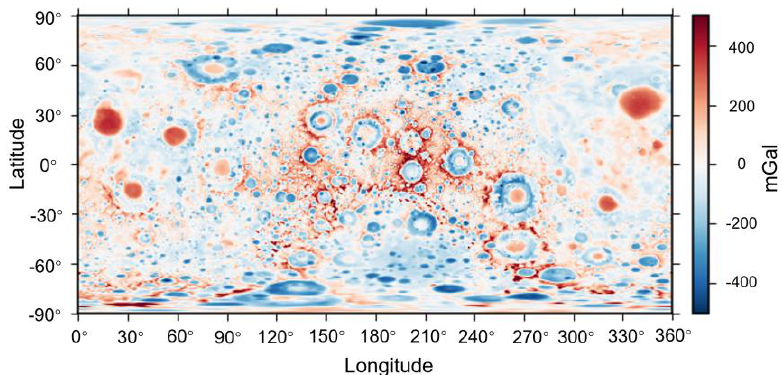
Figure 1. The gravity anomaly map including the gravitational effect of finite-amplitude topography (Source from: National Aeronautics and space administration).